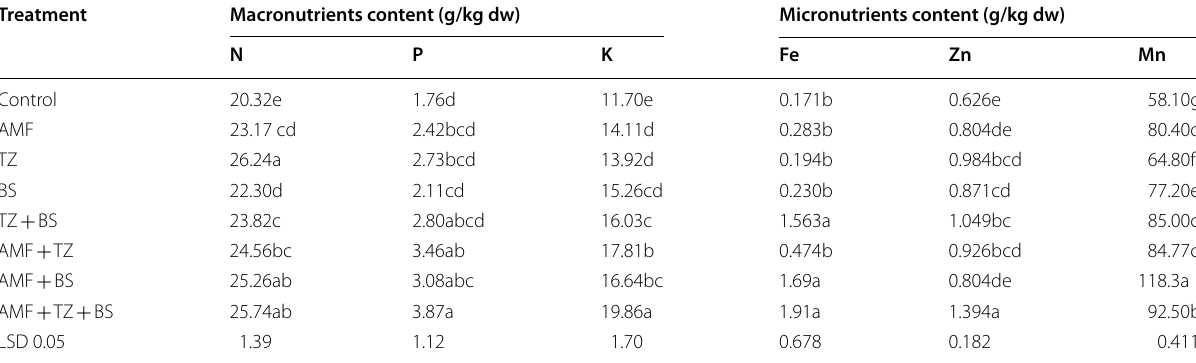
Means in a column followed by the same letters are not significantly different (LSD, P < 0.05). Arbuscular Mycorrhizal fungi (AMF), Trichoderma harzianum ( TZ ) , Bacillus subtills (BS), control (without treatment), dw (dry weight )